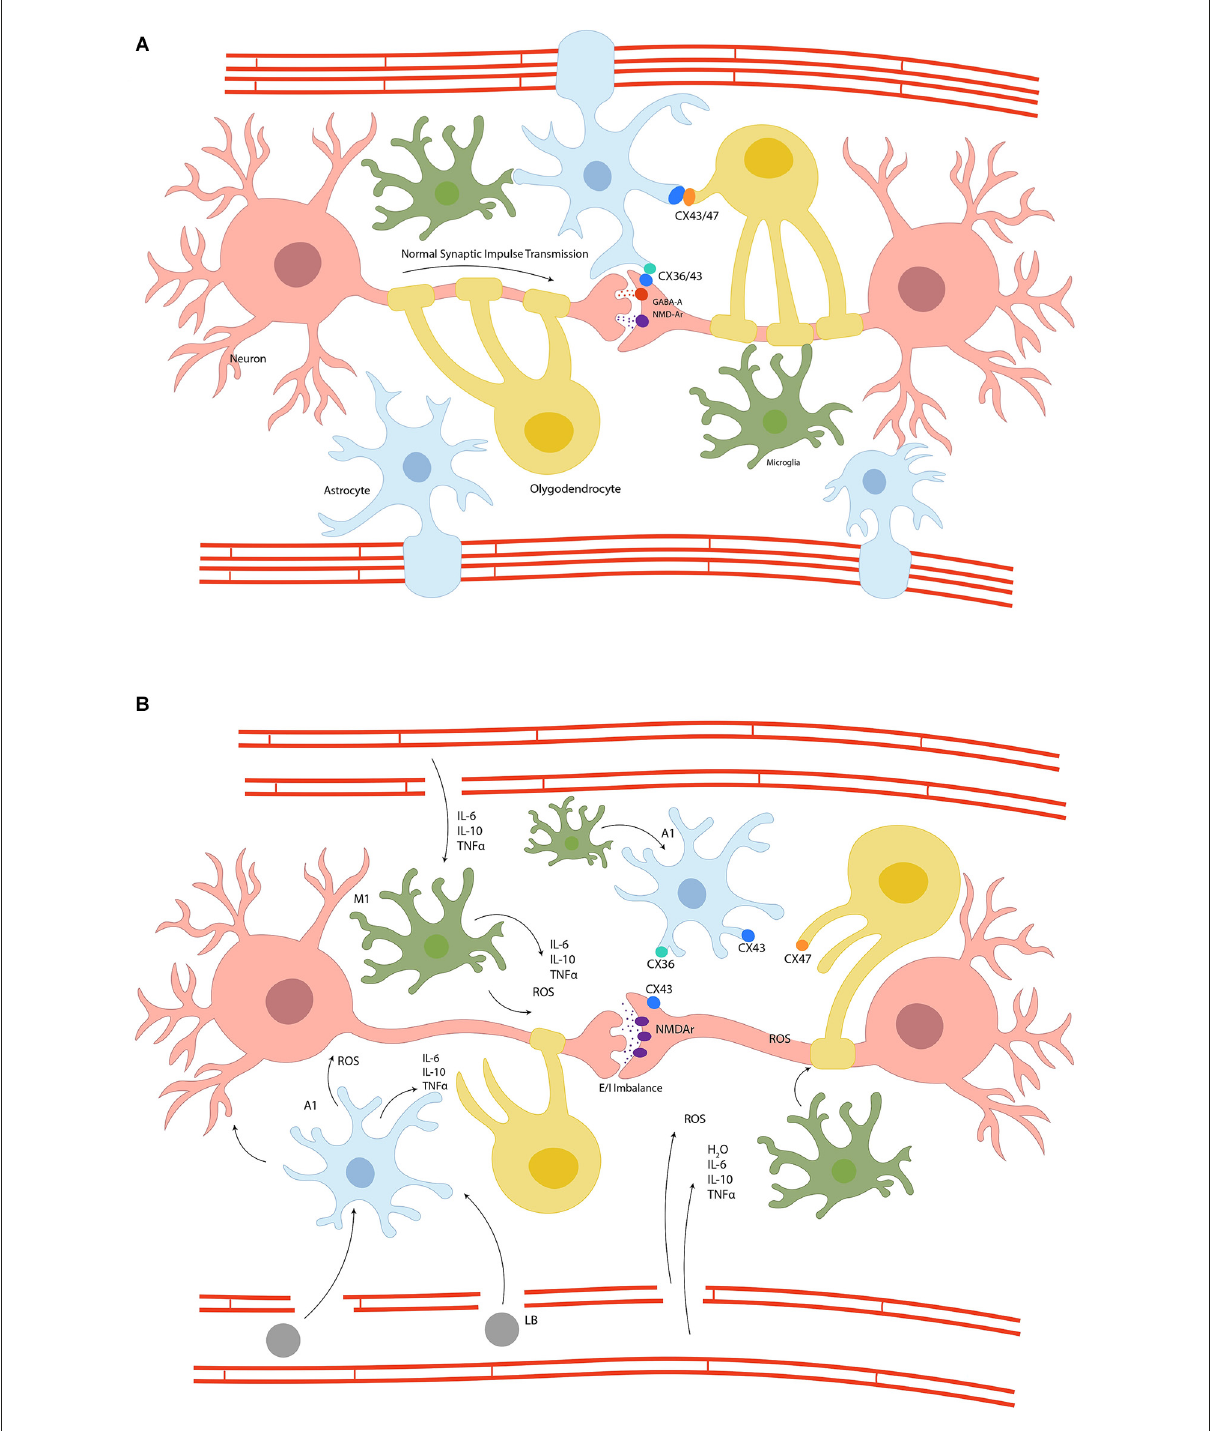
FIGURE2 Panel (A) represents the glial syncytium, where astrocytes, oligodendrocytes, and neurons are coupled through connexins to stabilize the synapsis andtheblood-brainbarrier,preservinghomeostasisandthereforeanormalsynapticimpulsetransmission.Panel (B) schematizesthedisruptionof glial syncytium due to inflammation and metabolic dyshomeostasis. The switch of glial cells to proinflammatory phenotype results in connexins uncoupling, impedes synaptic stability and an excitatory/inhibitory imbalance, the leaking of blood-brain barrier and therefore migration of systemic inflammatory cells, increase oxidative stress, and the activation of apoptotic cascades ending in cellular death; Connexins (CX), N- methyl-D-Aspartate Receptor (NMDAr), Gamma-Aminobutyric acid-A (GABA-A), lymphocyte B (LB), Interleukin (IL), Tumour Necrosis Factor- alpha (TNF α ) reactive oxygen species (ROS), proinflammatory astrocyte (A1), proinflammatory microglia (M1), water (H 2